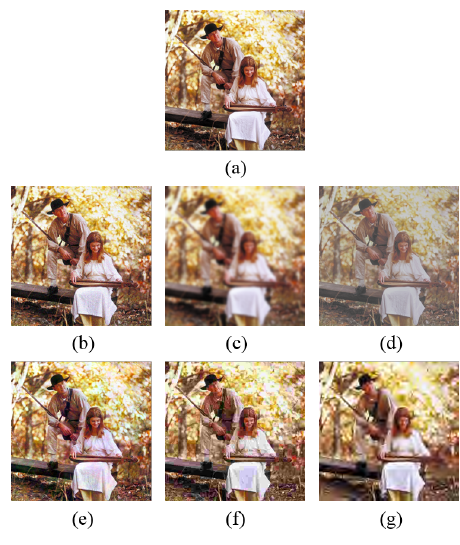
Figure 7. ( a ) A reference image. Distorted images of ( a ): ( b ) AWN; ( c ) GB; ( d ) CTD; ( e ) PGN; ( f ) JPEG; ( g ) JPEG2K. The difference MOS of ( b – g ) are 0.325, 0.785, 0.352, 0.265, 0.586 and 0.805,